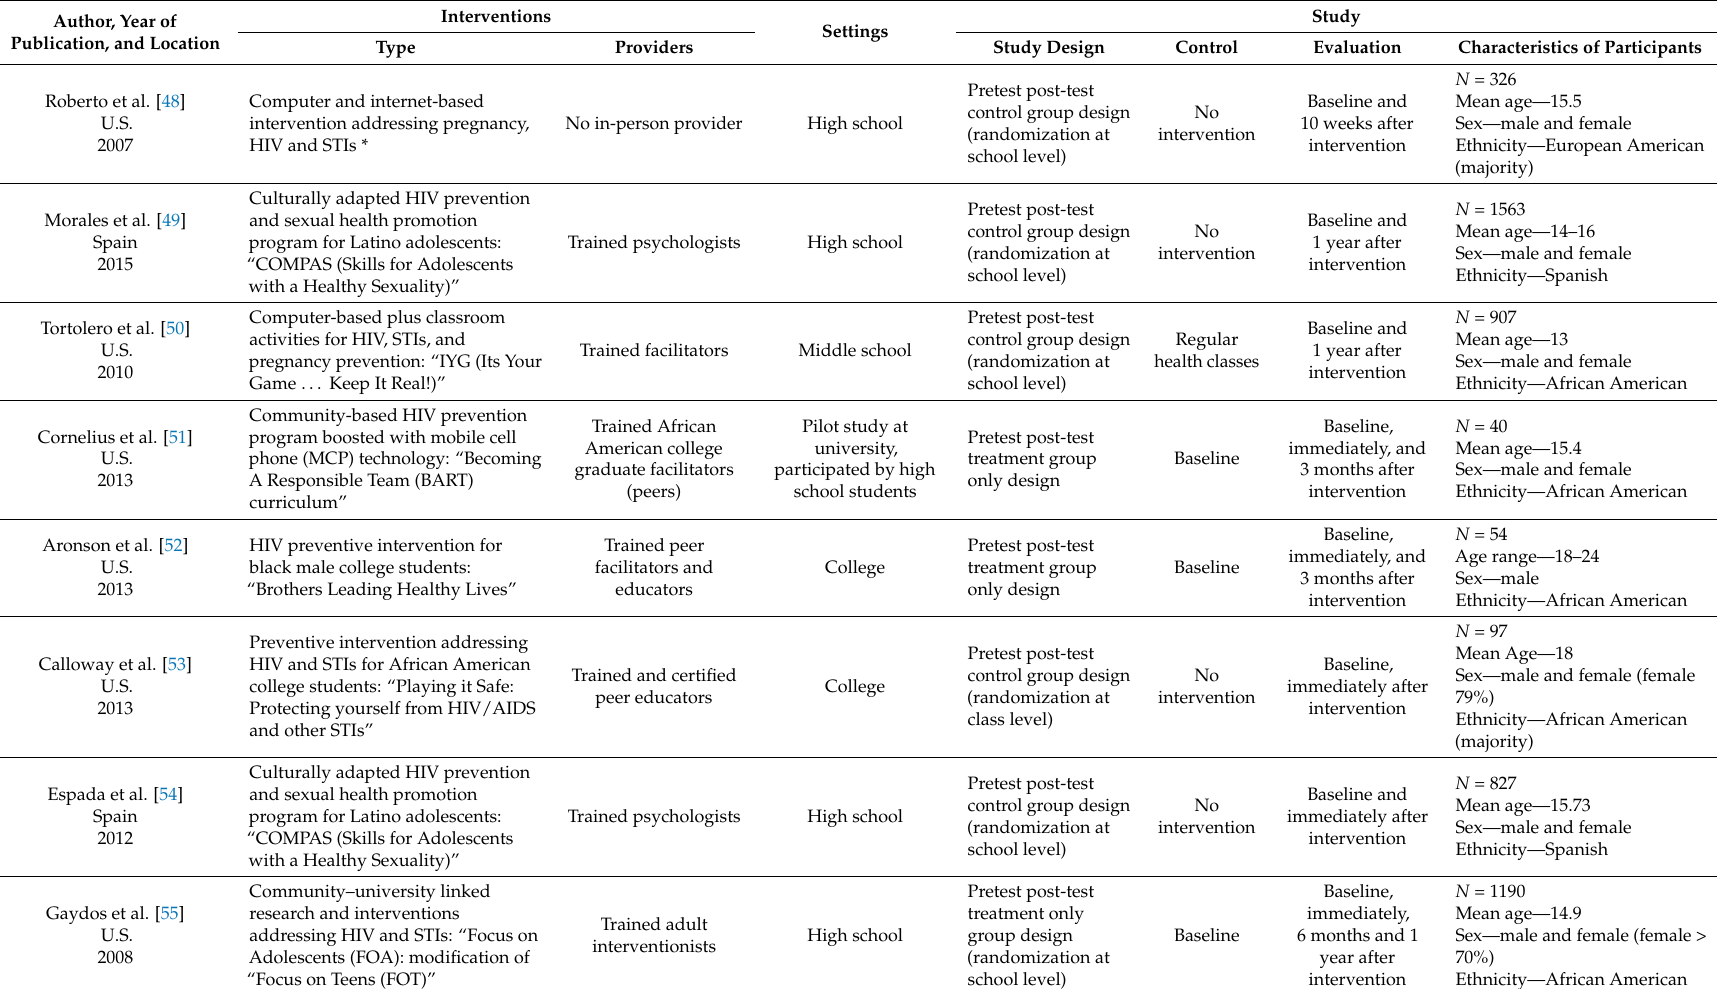
Table 2. Summary description of the included